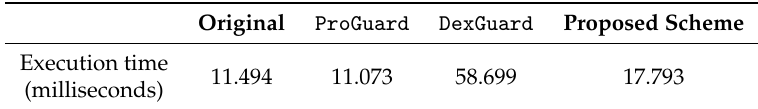
Table 3. Runtime